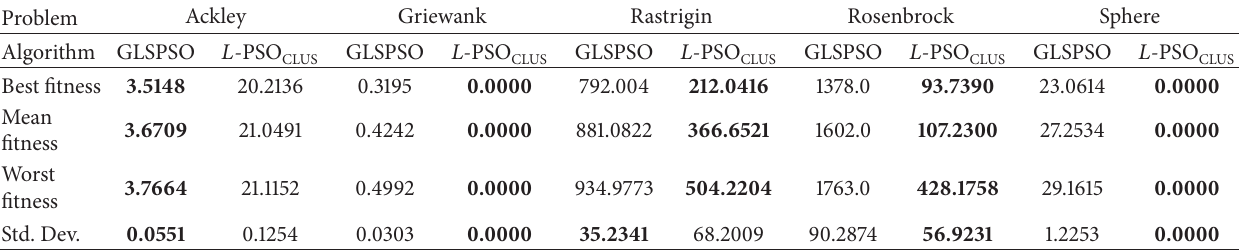
for problems with dimension of 100. CLUS